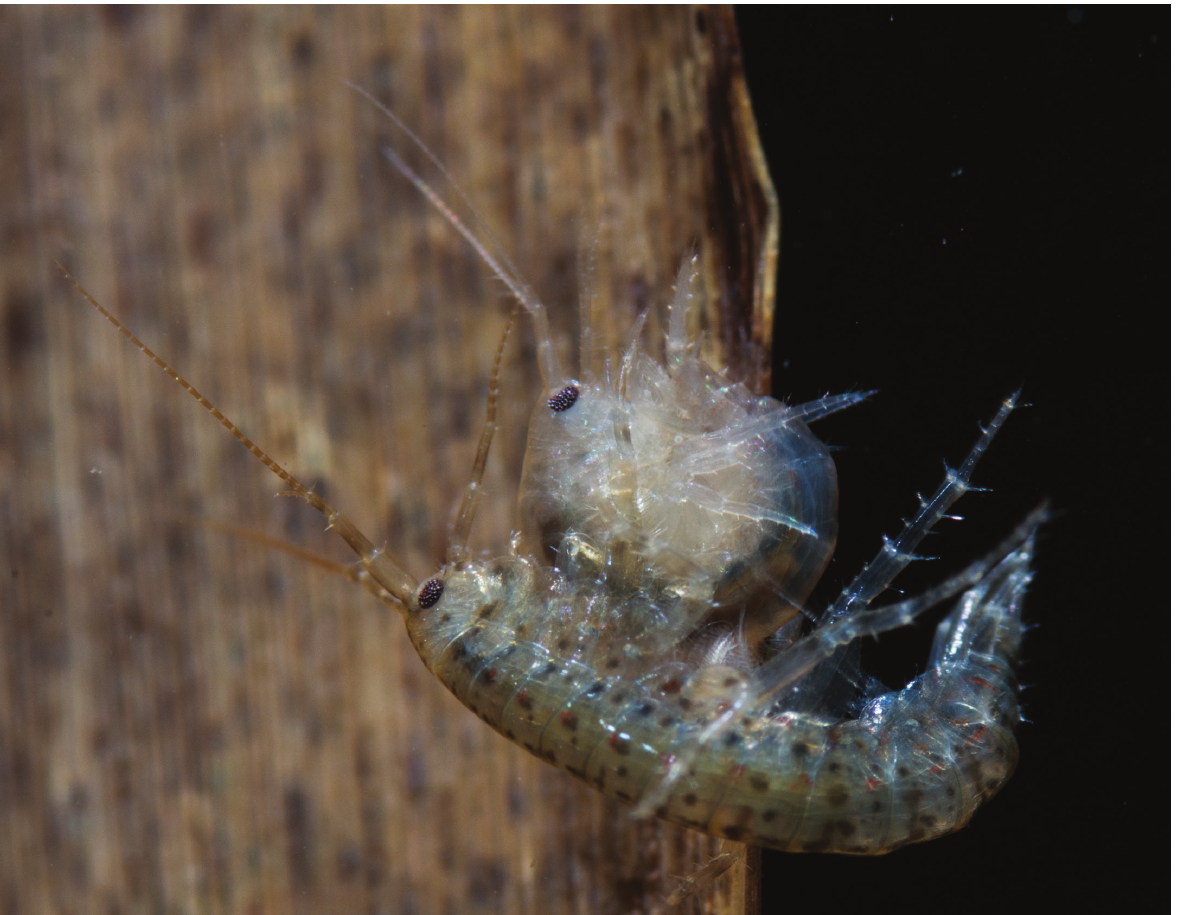
Figure 14. Jesogammarus uchiyamaryui sp. n., not preserved, precopula pair (male: upper, female: lower). Photographed by Ryu